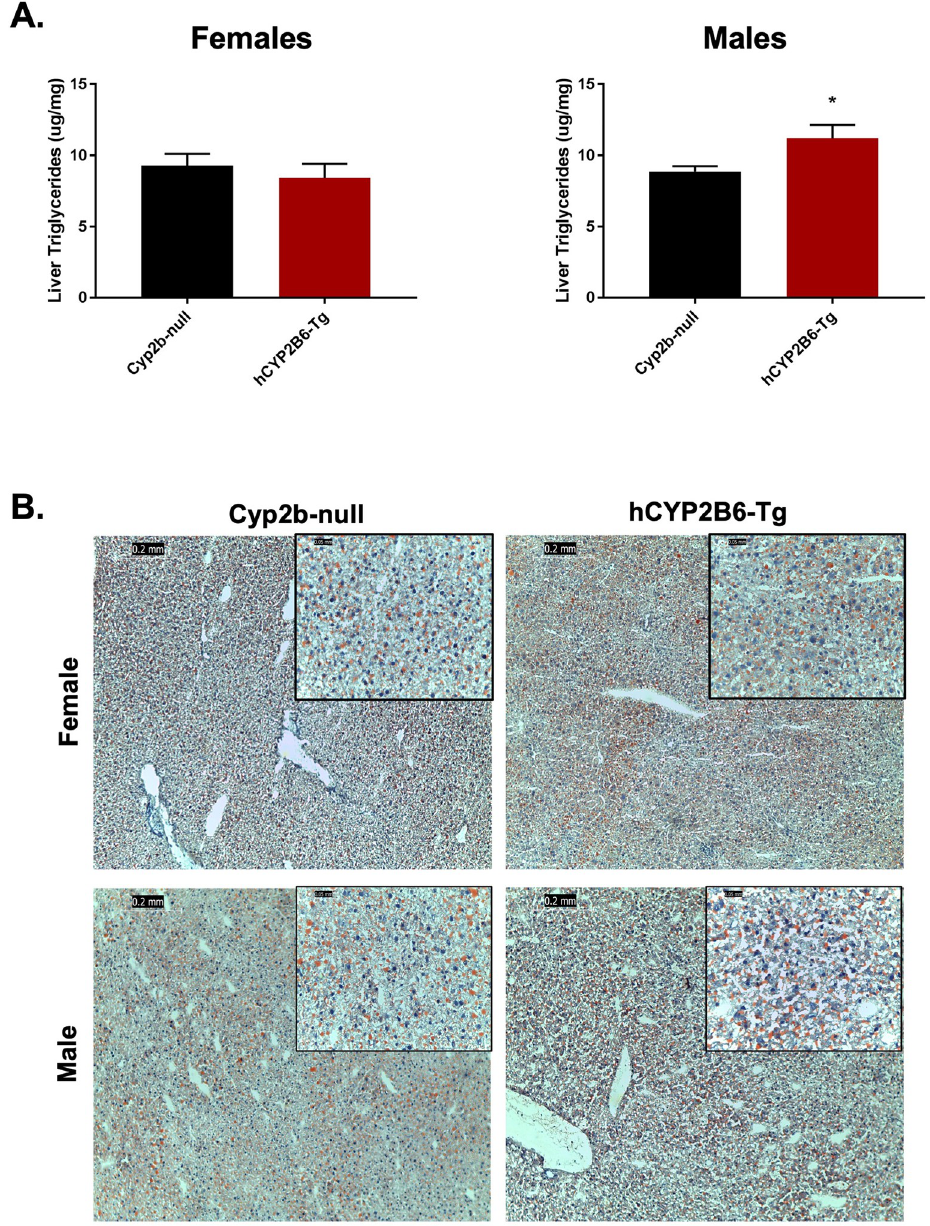
Fig 4. Comparison of steatosis markers in hCYP2B6-Tg and Cyp2b-null mice. (A) Total liver triglycerides were measured in Cyp2b-null and hCYP2B6-Tg female and male mice. Data are presented as mean + SEM. Statistical significance was determined by unpaired Student’s t-tests (n = 5). � indicates a p-value < 0.05. (B) Fatty liver histopathological changes were evaluated by Oil red O staining in female and male mice. Images were taken at 100x (0.2 mm) and 400x (0.05 mm)